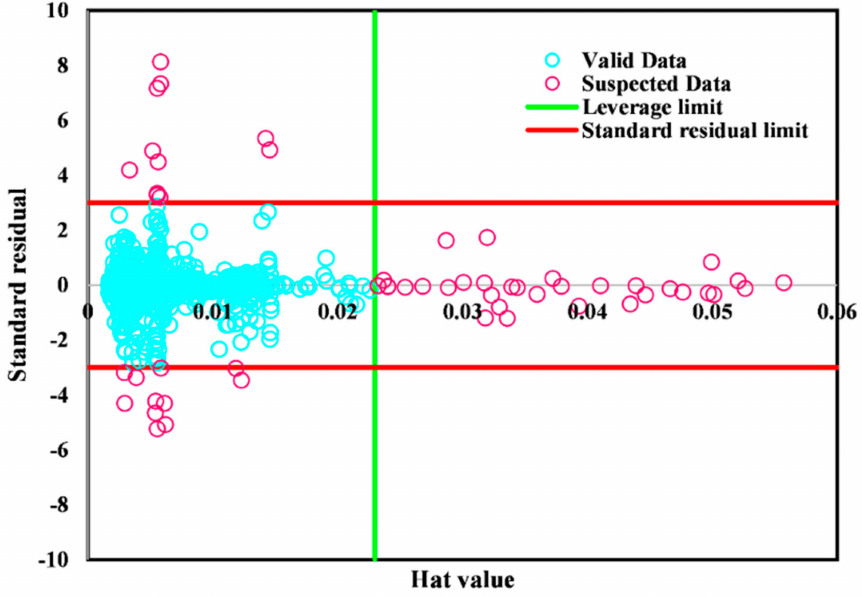
Figure 7. Detection of suspected data for hydrocarbon solubility